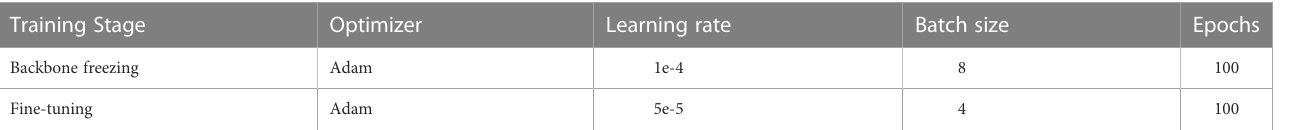
TABLE 2 The parameter setting in fi ne-tuning training.